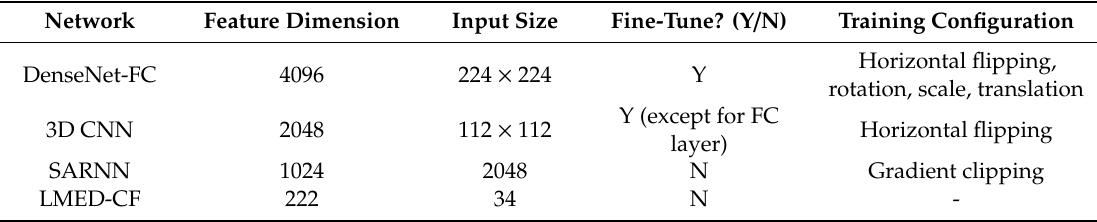
Table A1. Detailed configuration of each